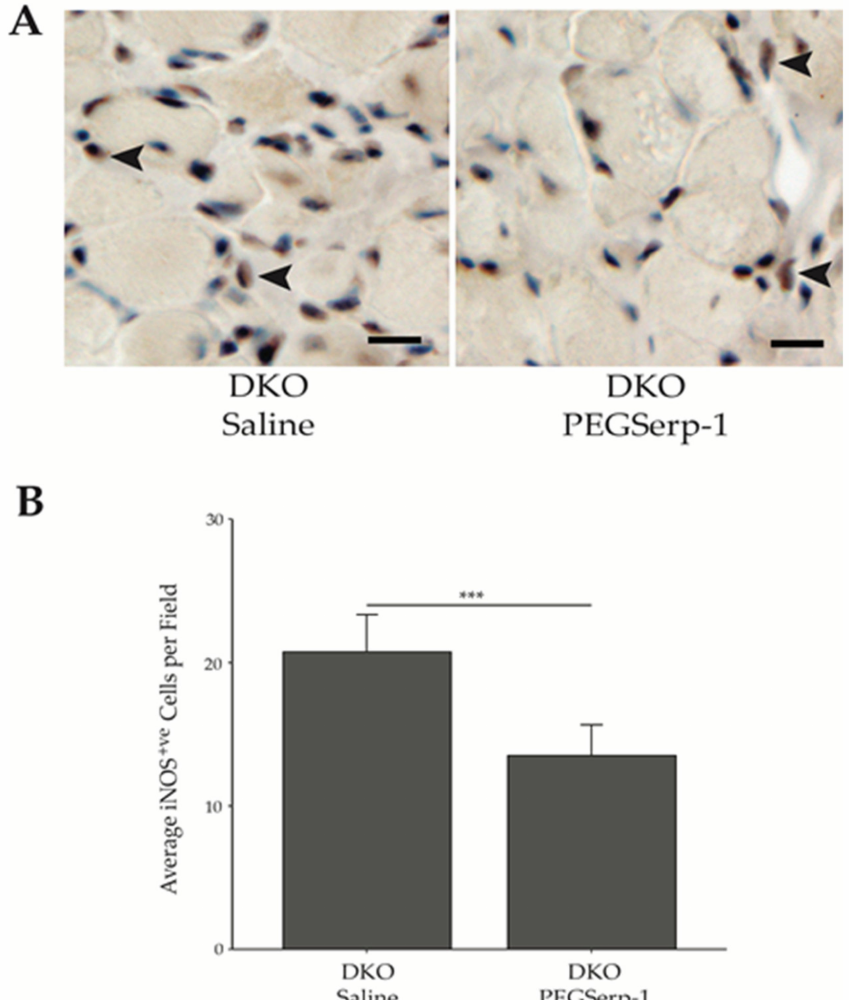
Figure 3. PEGSerp-1 regulation of iNOS+ve M1 macrophage infiltration. ( A ) Representative images of iNOS+ve M1 macrophages in the diaphragm of DKO mice treated with PEGSerp-1 or saline. IHC was performed using an anti-iNOS antibody and the proteins were visualized with DAB and counterstained with hematoxylin (see arrowheads). Scale bars = 10 µ m. ( B ) iNOS+ve cells were counted in PEGSerp-1- and saline-treated DKO diaphragms. Data are presented as average number of positive cells per field ± s.d., *** p <